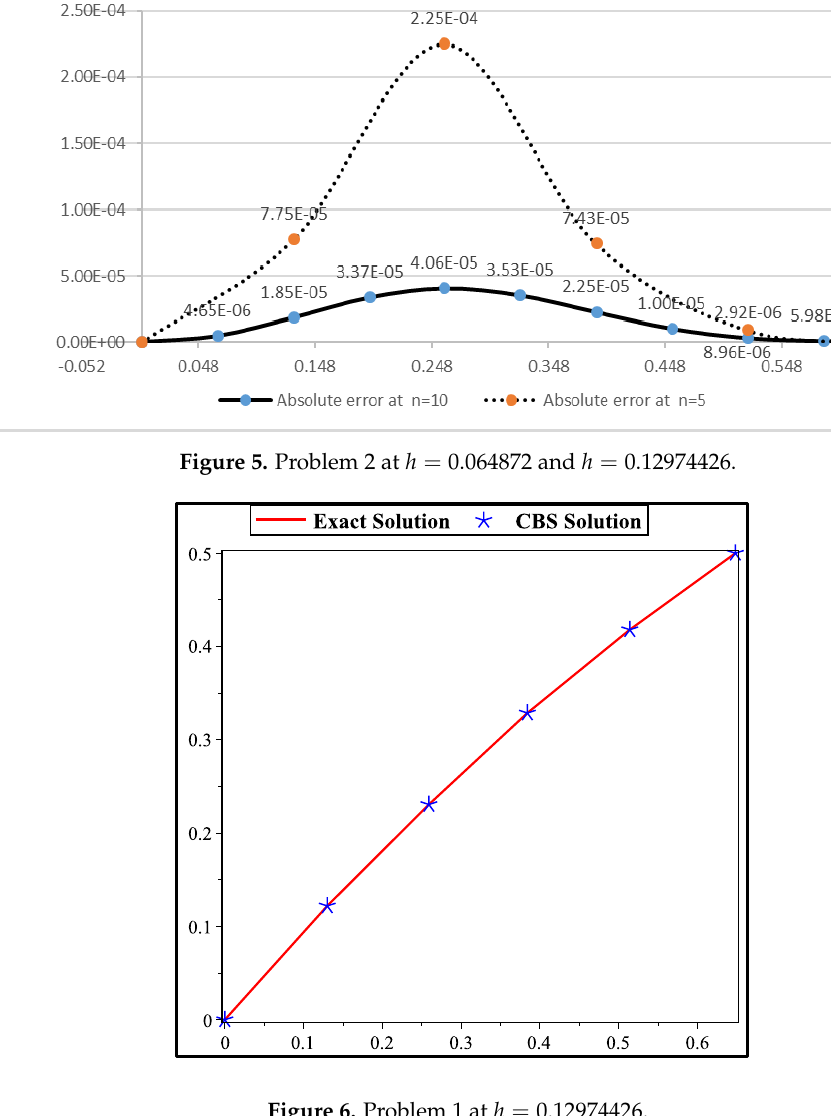
Figure 6. Problem 1 at h = 0.12974426. Table 6. Analyzing the exact solution and CBS solution of problem 2 at h =